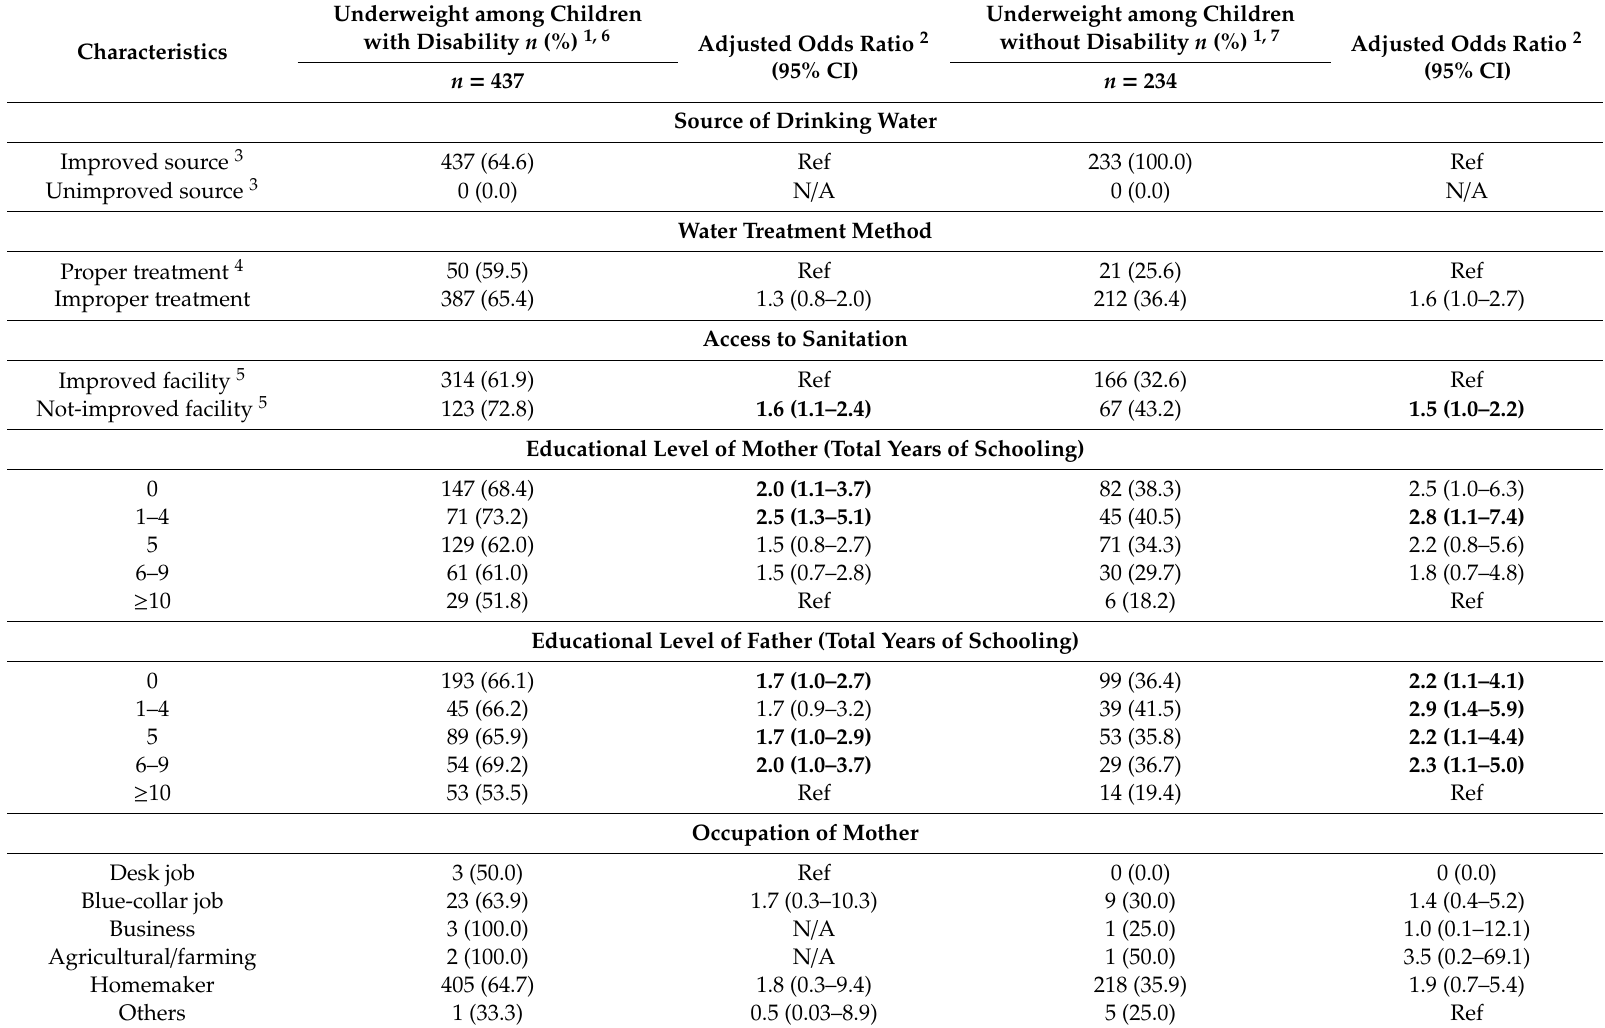
Table 6. Relationship between socioeconomic characteristics and